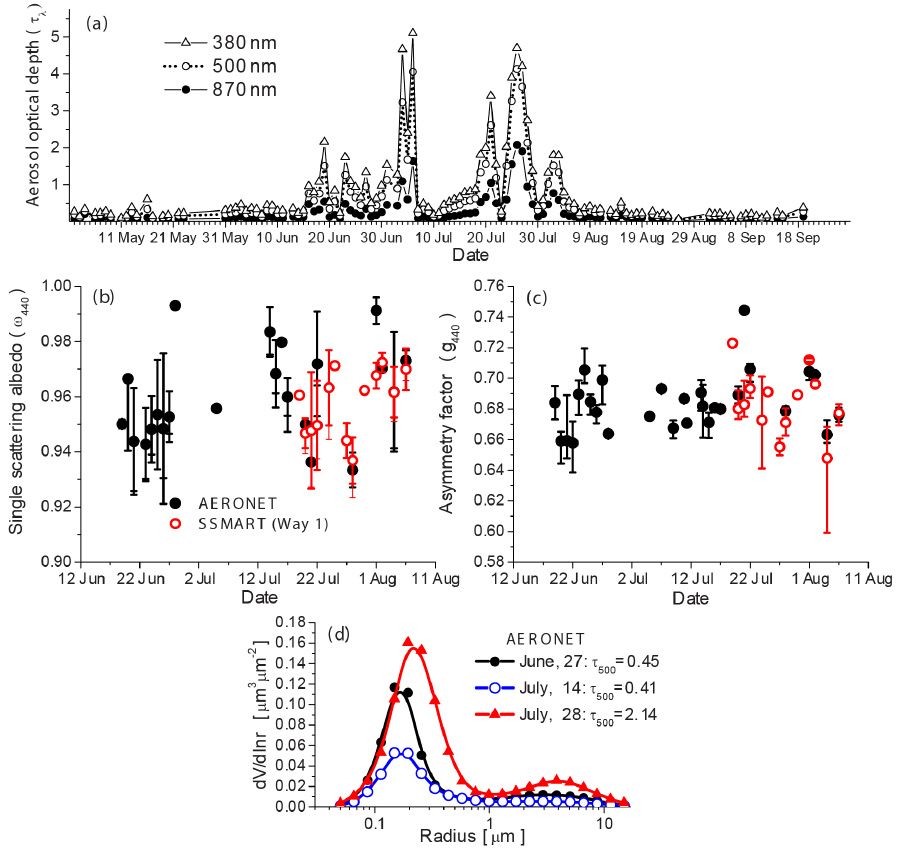
Figure 3. (a) Daily average AOD, (b) single scattering albedo and (c) asymmetry factor time series, and (d) examples of particle size distribution in Tomsk-22 during the summer period of 2012.